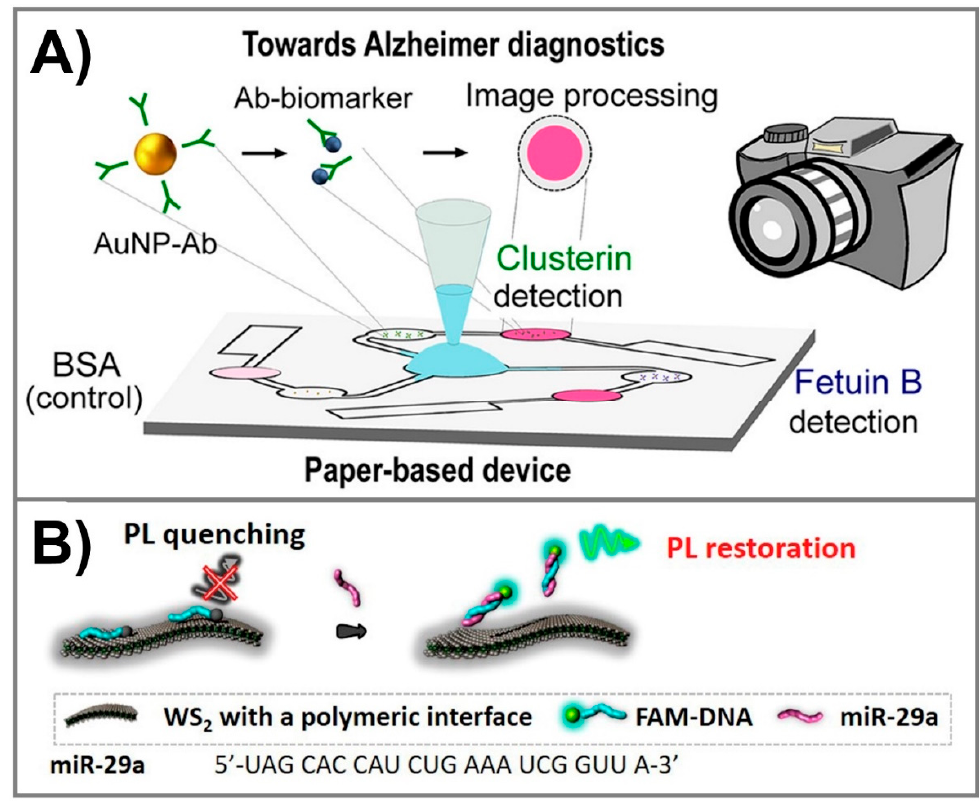
Figure 2. ( A ) Colorimetric lateral flow paper device using AuNPs for the detection of clusterin and fetuin B biomarkers of Alzheimer’s disease (AD). Adapted with permission from Ref. [51]. ( B ) Schematic depiction for the fluorescent detection of the miR-29a AD biomarker on WS2 nanosheets with polymeric interfaces. Adapted with permission from Ref. [59].